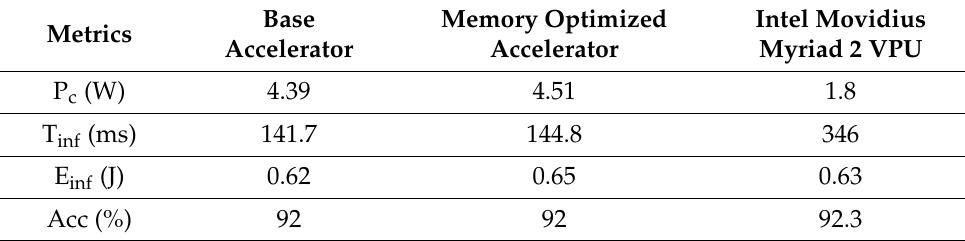
Table 3. Measured